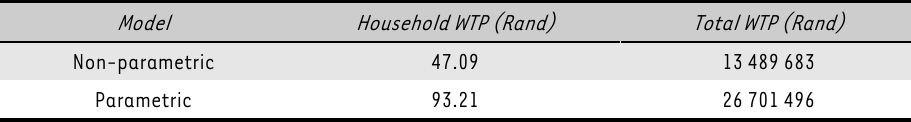
TABLE 7: Aggregate WTP estimates: parametric vs. non-parametric Model Household WTP (Rand) Total WTP (Rand) Non-parametric Parametric 93.21 Source: Authors’